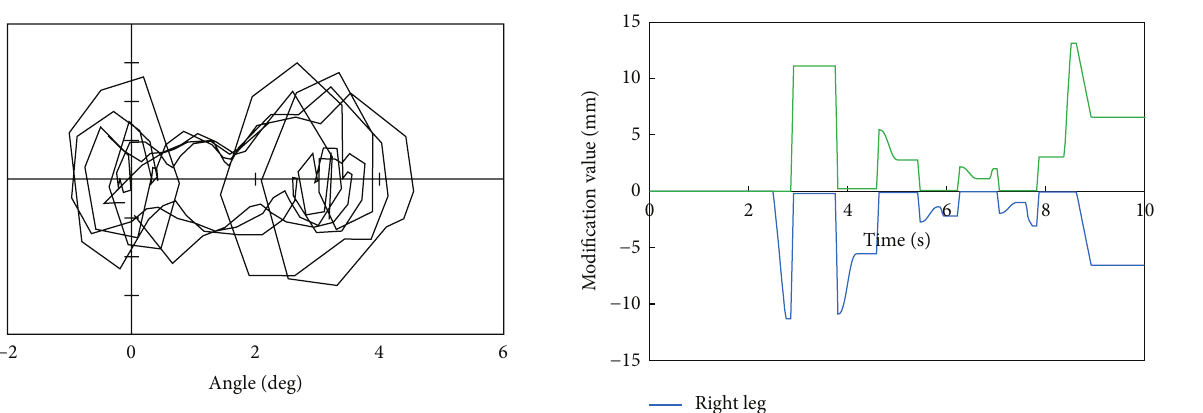
Figure 9: Phase portrait when walking with 90 mm breadth feet.